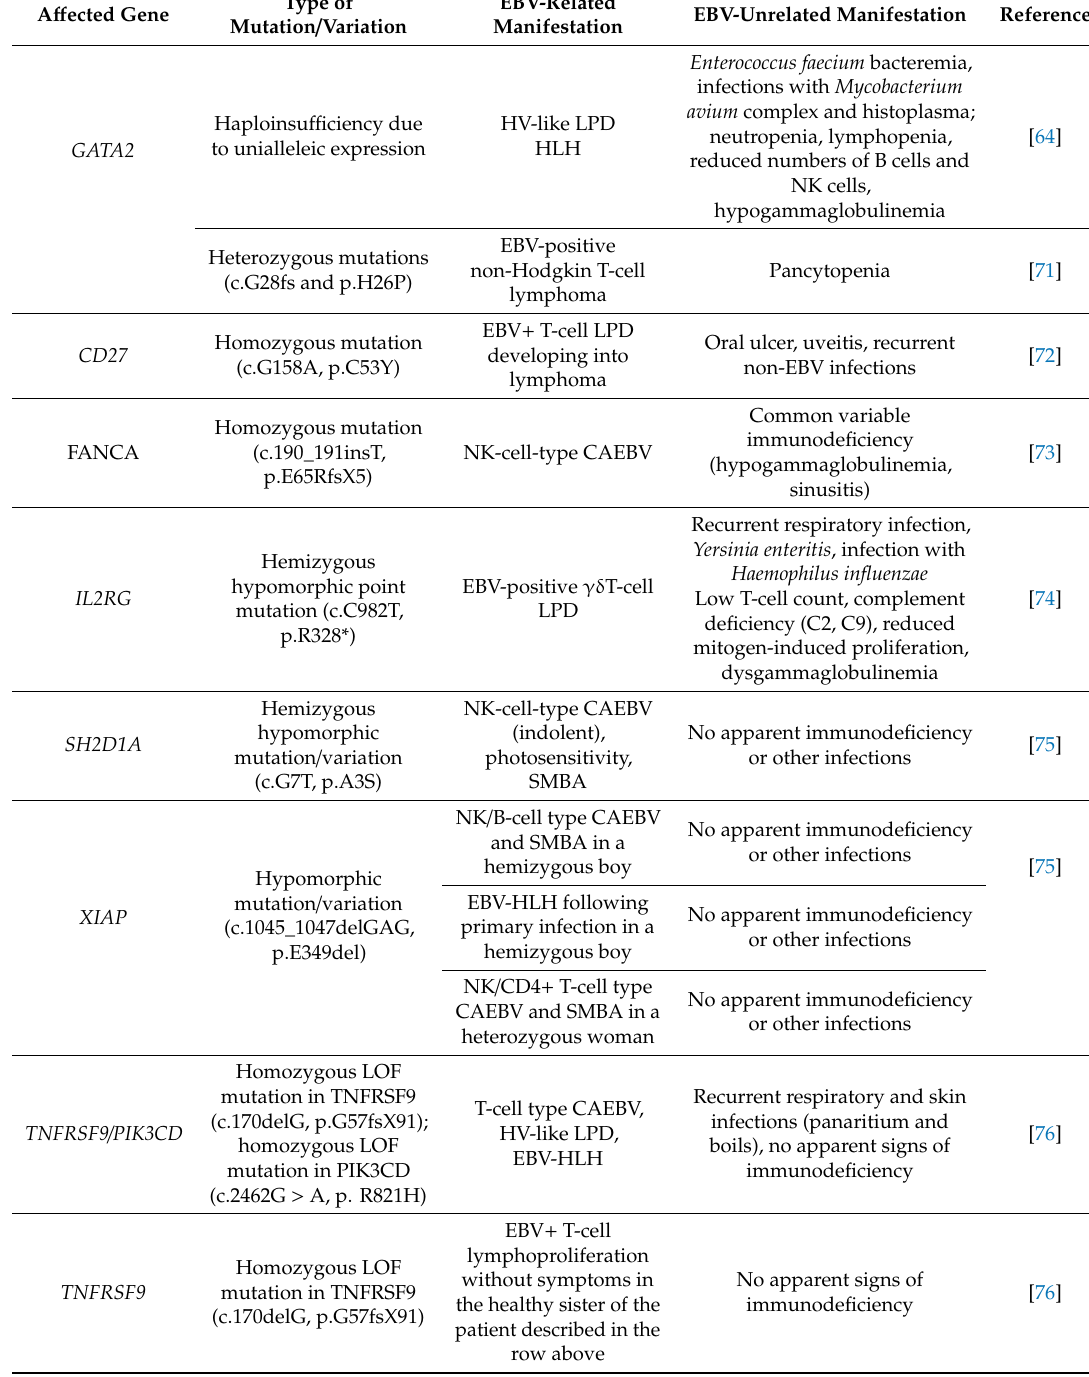
Table 1. Mutations / variations in immune-related genes detected in patients with Epstein–Barr